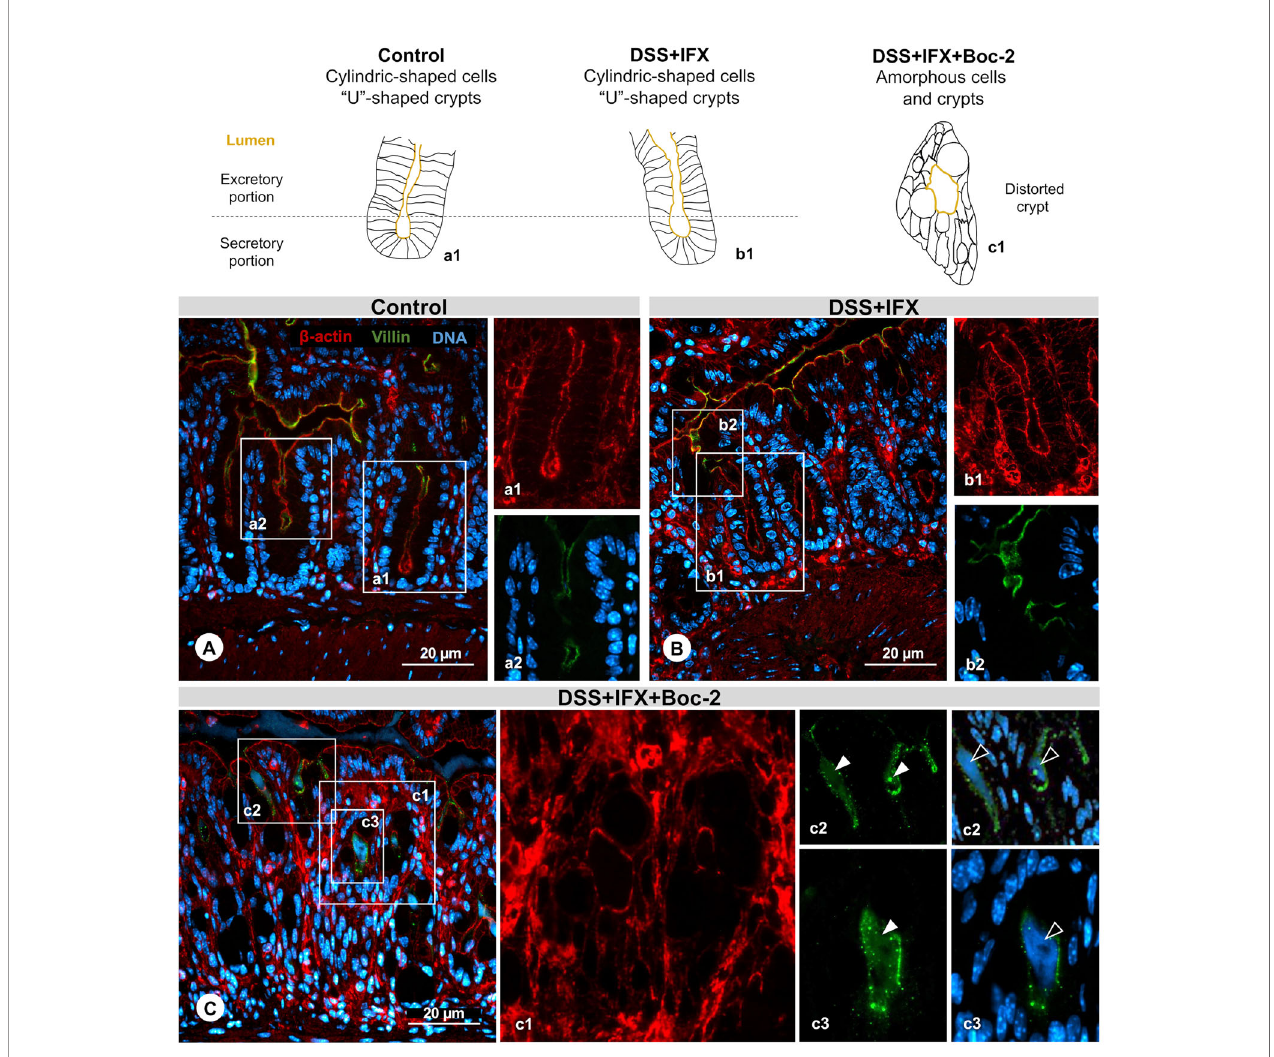
FIGURE 3 | Crypt regeneration mediated by in fl iximab (IFX) requires formyl peptide receptor (FPR) signaling. (A) Control: cylindrical-shaped cells forming a U-shaped crypt revealed by b -actin staining ( a1 , red ). Presence of villin ( a2 , green ) in the inner surface from the excretory part of the crypt lumen. Representation of a normal structure. (B) DSS+IFX: preserved crypt morphology resembling the control condition ( b1 and b2 ). (C) DSS+IFX+Boc-2: defects in crypt closure ( c1 ); presence of villin ( c2 and c3 , white arrowheads ); and DNA residue ( c2 and c3 , black arrowheads ) in the crypt lumen. n = 4 – 6 mice/group. Embedding, paraf fi n; sections, 3 m m. Bars, 20 m